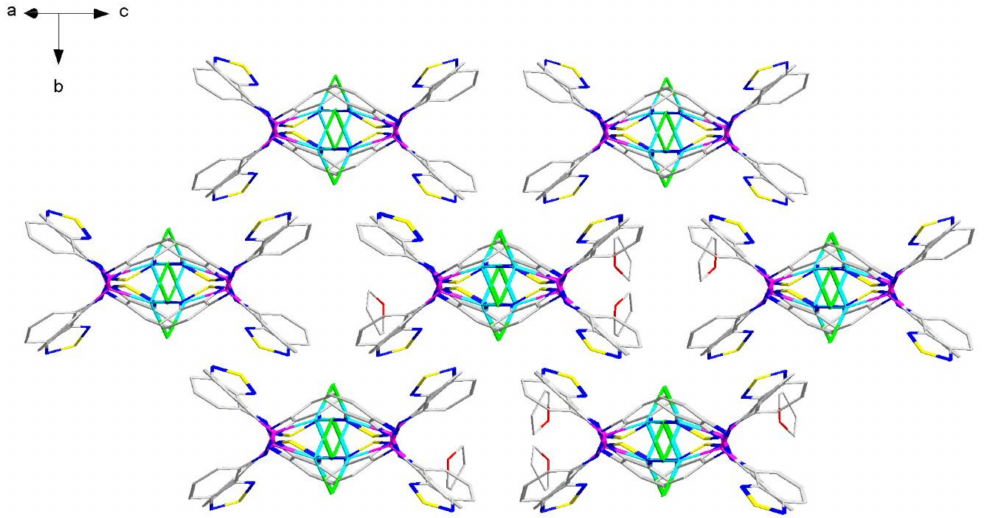
Figure 10. Crystal packing for 3 · THF. Hydrogen atoms are not